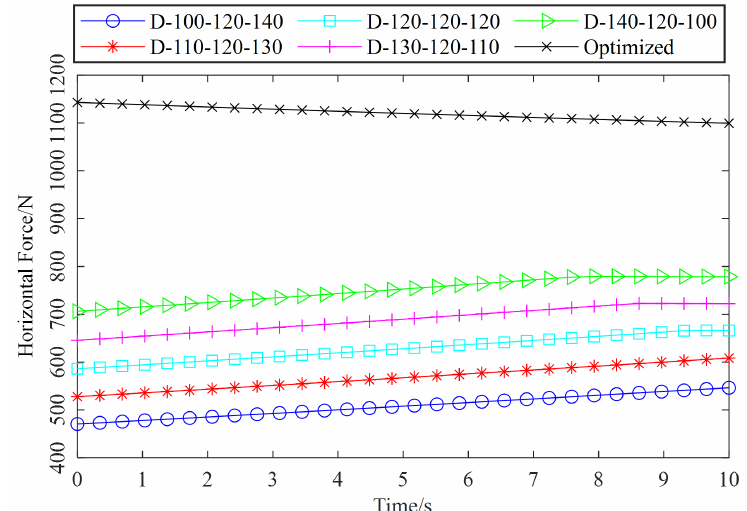
Figure 8. Comparison of the maximum reachable horizontal forces obtained by different distributions of the unit diameters along the same given trajectory. (‘D’ denotes ‘diameter’, and the numbers after D represent the diameters of each unit. For example, ‘D-100-120-140’ represents that the diameters of the 1st, 2nd, and 3rd units are respectively 100, 120, and 140